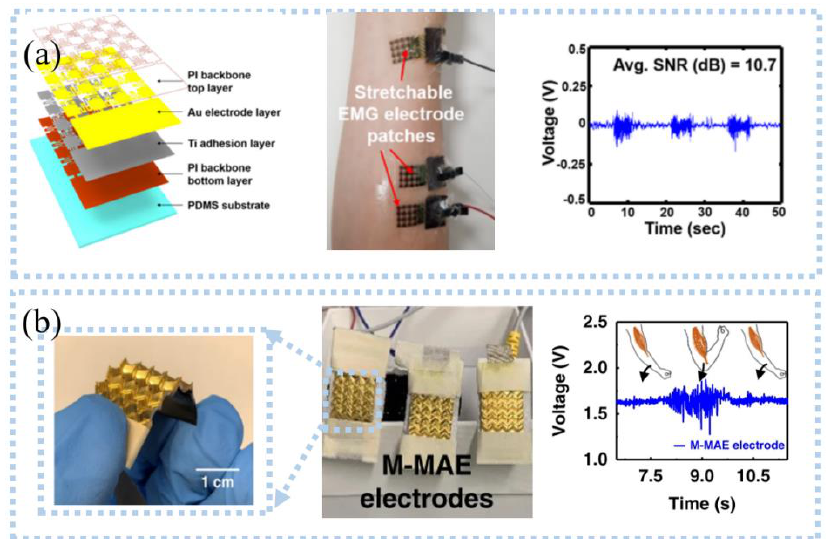
Figure 4. Detection of EMG signals: ( a ) photographic image of the ultrathin, stretchable electrode patch (left), wireless epidermal EMG sensing system (middle), and EMG signals in clenching a fist motions (right). Reprinted with permission from Ref . [52]. Copyright 2020 MDPI, ( b ) pyramid — microneedle electrodes (left), EMG acquisition device with M−MAE (middle), and EMG signals for two arm–bending cycles (right). Reprinted with permission from Ref . [58]. Copyright 2020 Springer Nature.